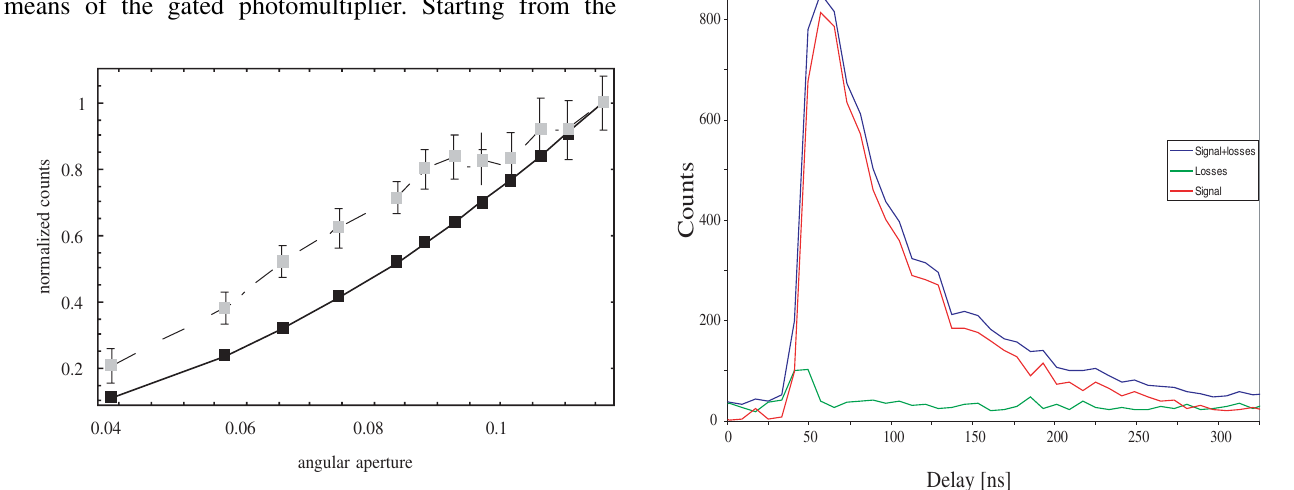
FIG. 12. Counting experiment for different angular apertures. The squares following the continuous line indicate the theoreti- cal values for an isotropical emission. The other points give the experimental data.